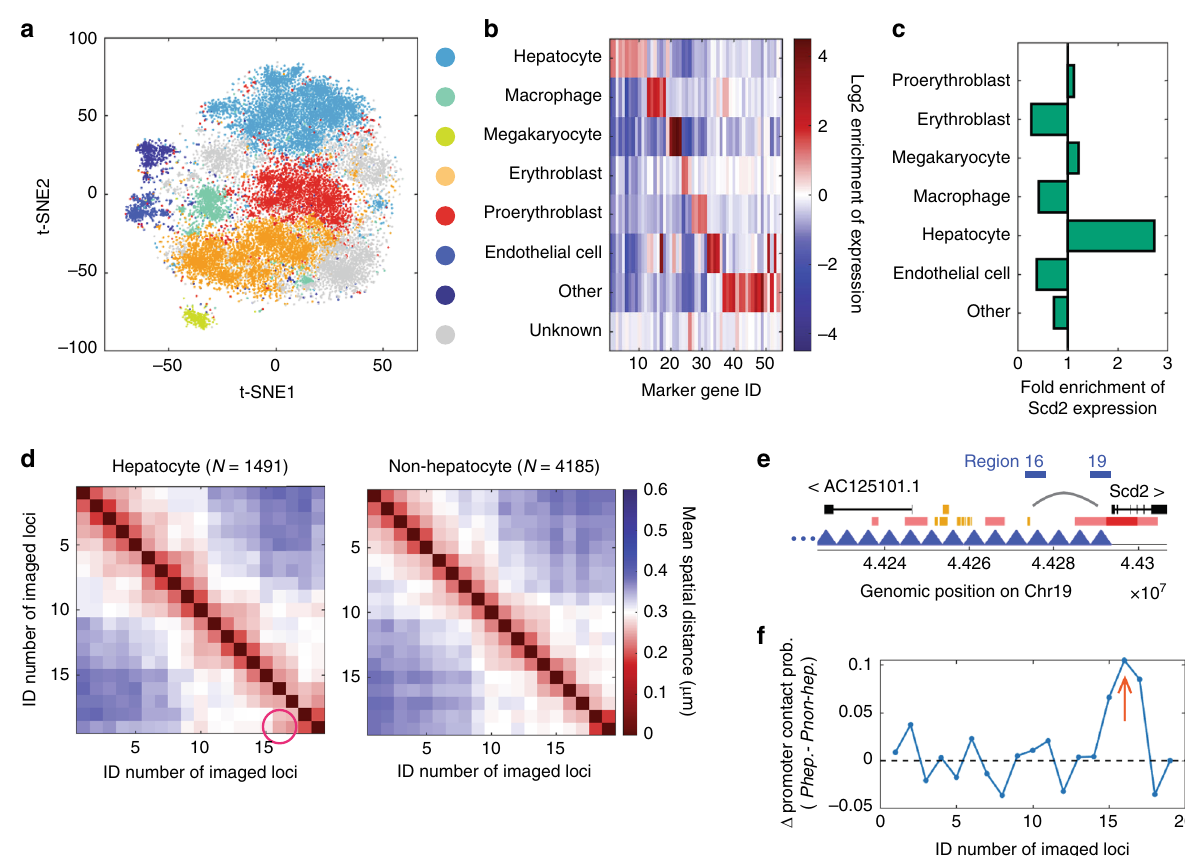
Fig. 2 Cell-type-speci fi c chromatin folding at the promoter-enhancer length scale. a t-distributed stochastic neighbor embedding (t-SNE) plot of single- cell RNA pro fi les with pseudo-colored clusters that correspond to different cell types. b Average gene expression pro fi les of probed cell-type marker genes for the different clusters in A. Cell types were identi fi ed based on the enrichment of different marker genes. c Fold enrichment of Scd2 RNA copy numbers in different cell types. d Mean spatial distance matrices of the 19 5-kb loci upstream of Scd2 in hepatocytes (left) and non-hepatocytes (right). The magenta circle highlights a decreased distance in hepatocytes that suggests looping contact between the corresponding loci. e Gene regulatory annotations of the genomic region upstream of Scd2 . Red: promoters. Pink: promoter fl ank regions. Orange: enhancers. Blue: probed 5-kb regions. f Difference in contact probabilities of each locus with Scd2 promoter (locus 19) in hepatocytes versus non-hepatocytes. Arrow: contact between locus 16 and Scd2 promoter. Source data are provided as a Source data fi